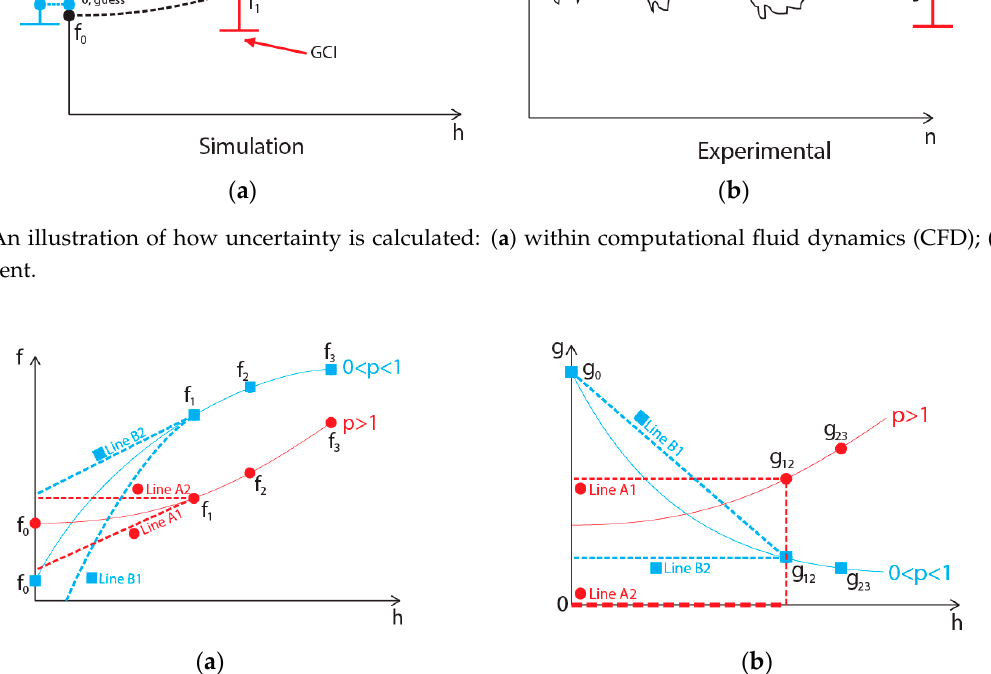
Figure 2. A visual representation of how the limiting value is calculated with the suggested model: ( a ) on the simulation data; ( b ) on the gradient.